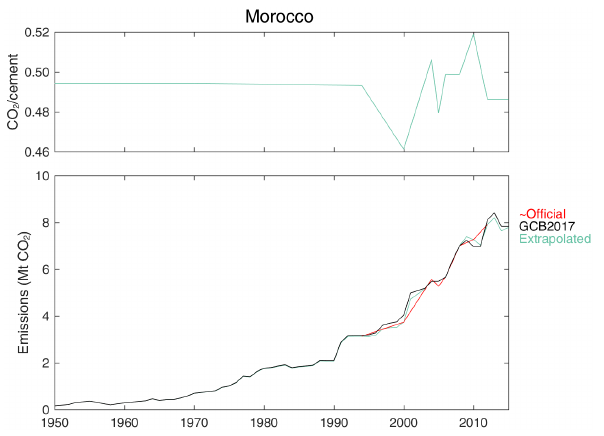
Figure C30. Revised cement emissions for Morocco.